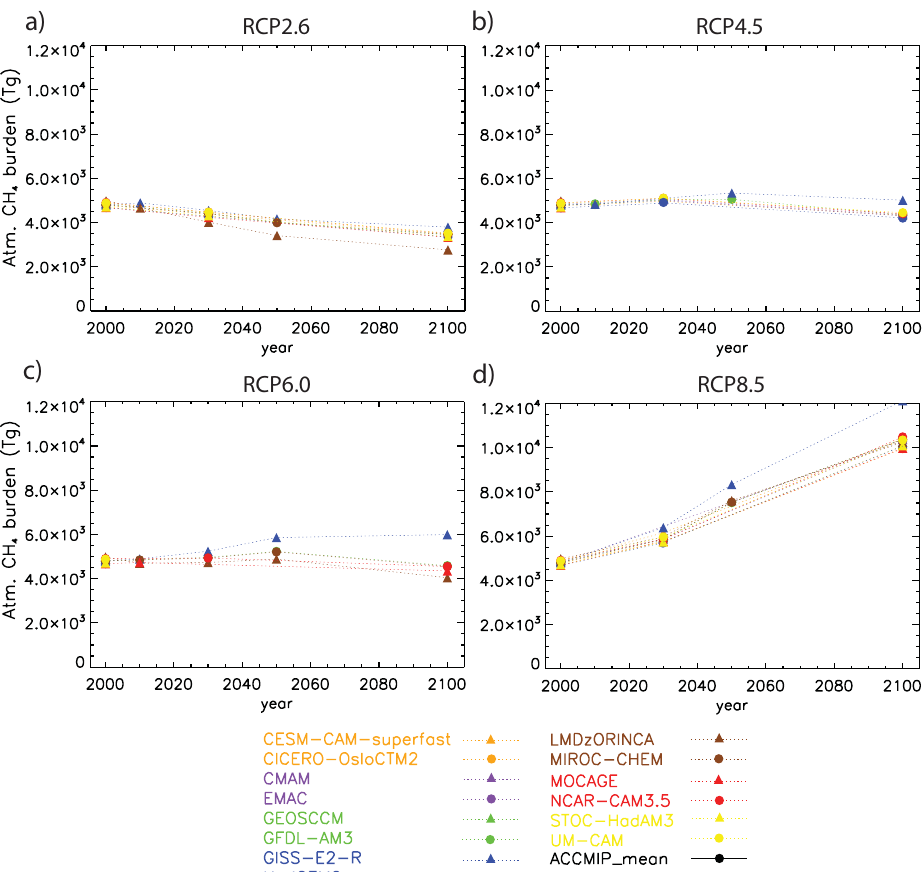
Fig. 3. Evolution of global atmospheric methane burden in the ACCMIP models, for the four different future RCP scenarios. Multi-model mean values (black dots connected with solid line) were only plotted for timeslices with data from at least 8